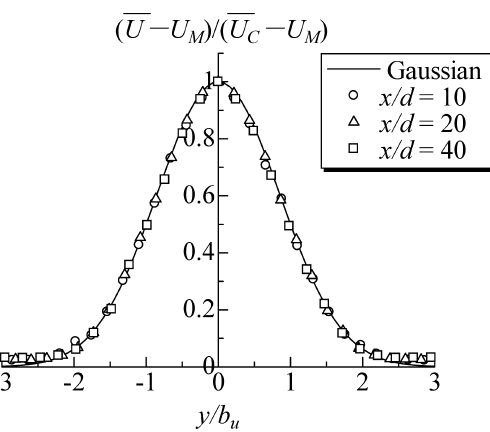
Fig. 2 Cross-streamwise profiles of mean streamwise velocity.